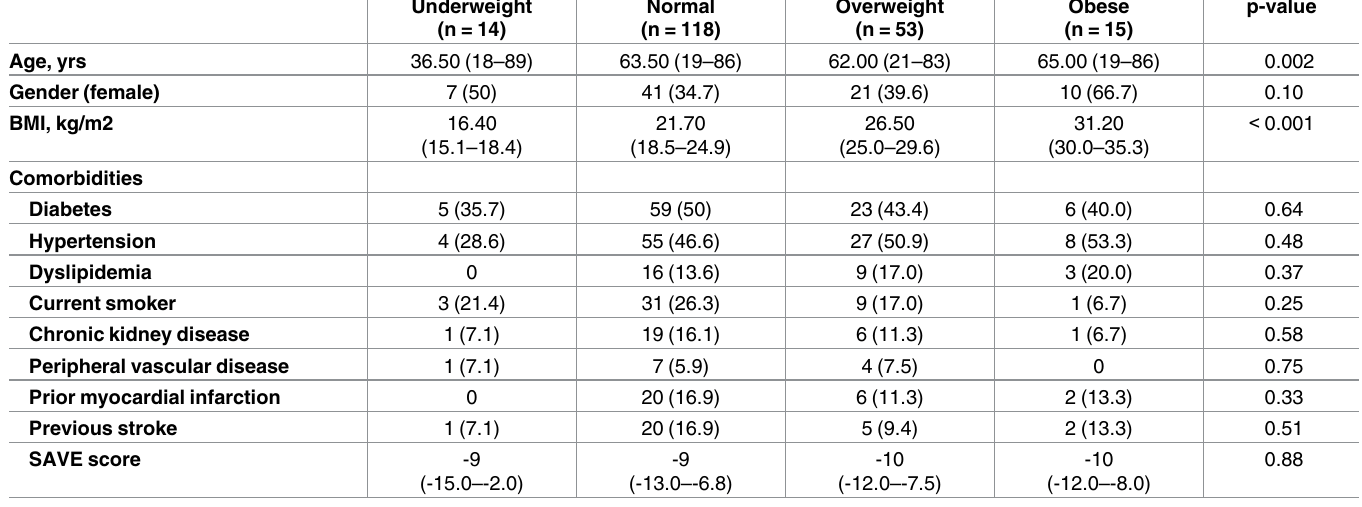
Table 1. Baseline patient